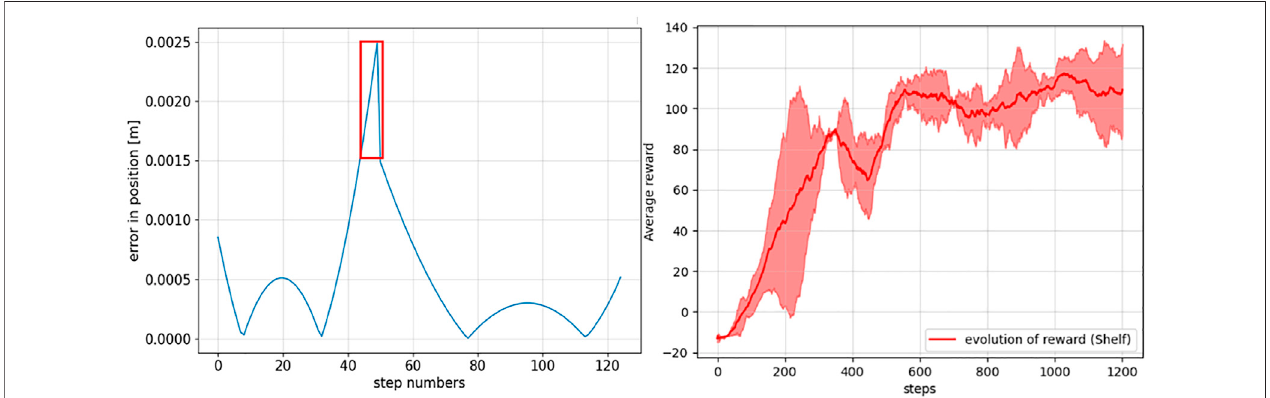
FIGURE 4 | Left: absolute prediction error between the ground truth and the Koopman operator – based human intent model predicted end-effector positions at different steps. The region with a higher prediction error ismarked as ared box where human intervention toprovide reward is preferred. Right: evolution of the episodic cumulative rewards averaged over 100 episodes.